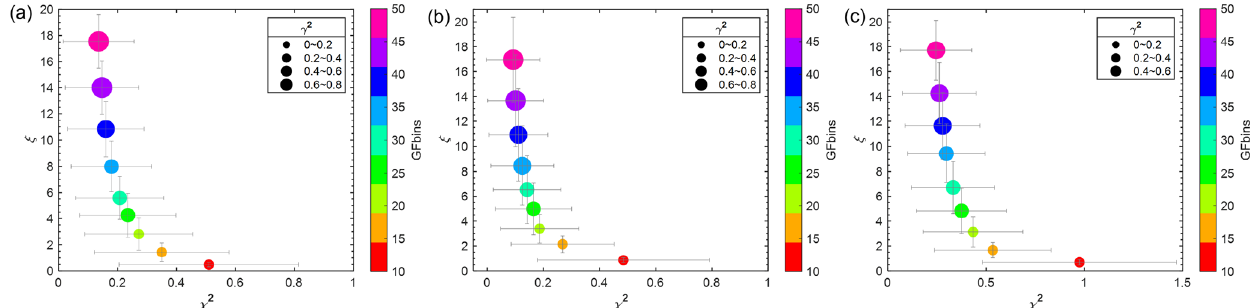
Figure 1. L-curve showing the dependence of reconstruction residual, χ 2 , and the smoothness, ξ , on the number of GF bins of pre-defined GF-PDFs with (a) one mode, (b) two modes, and (c) three modes, respectively. The symbol size represents the error in the inverted GF-PDF, γ 2 . Whiskers represent standard deviation. The inversion is conducted using Twomey’s method. (cid:30)(cid:114) (cid:16) (cid:17) R i, s + α 2 R 2 as 1 , which accounts for both Poisson i, s and Gaussian noises. The results are essentially the